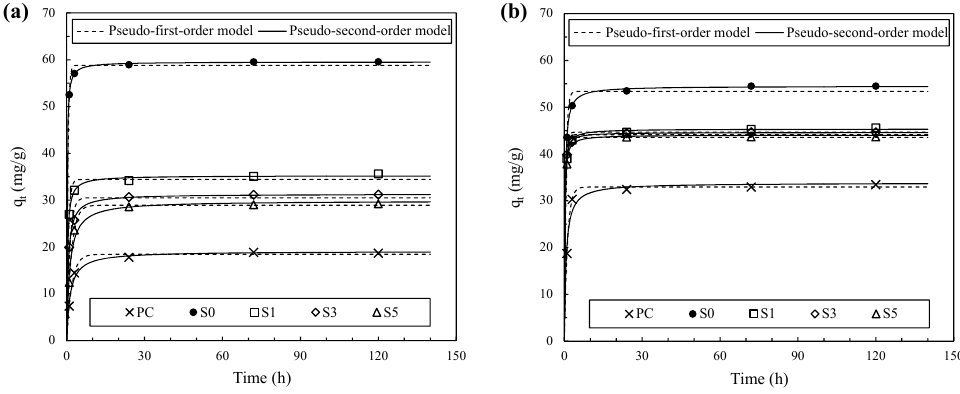
Figure 3. Adsorption capacities and kinetic modelings of ( a ) cesium and ( b ) strontium adsorptions on various binder types. Table 3. Parameters of kinetic models of cesium adsorptions on various binder types. Experimental Binder